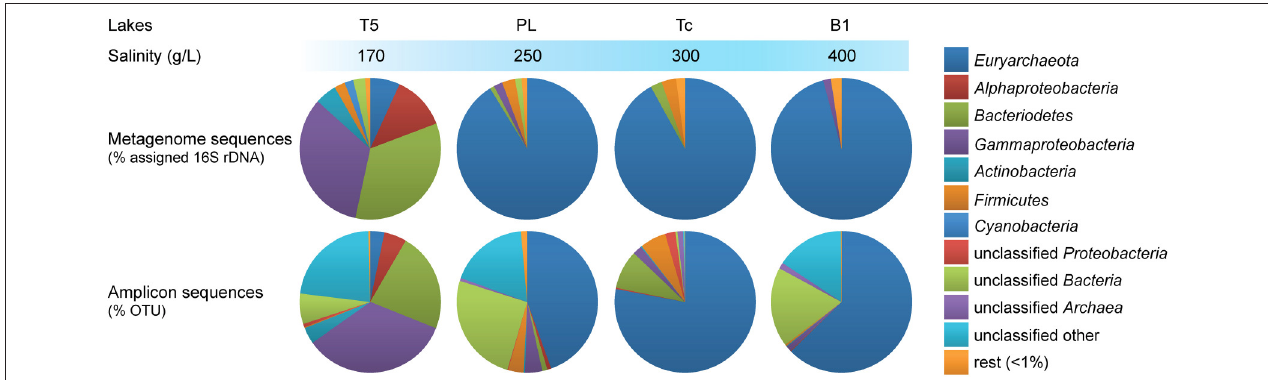
FIGURE 1 | Taxonomic profiles of the microbiota from hypersaline soda lake brines. Top : distribution of sampled metagenomic reads encoding fragments of 16S rRNA genes assigned to top level taxa. Bottom : distribution of the OTUs assigned to the amplicon sequences. T5, Tanatar-5; PL, Picturesque Lake; Tc, Tanatar trona crystallizer; B1,